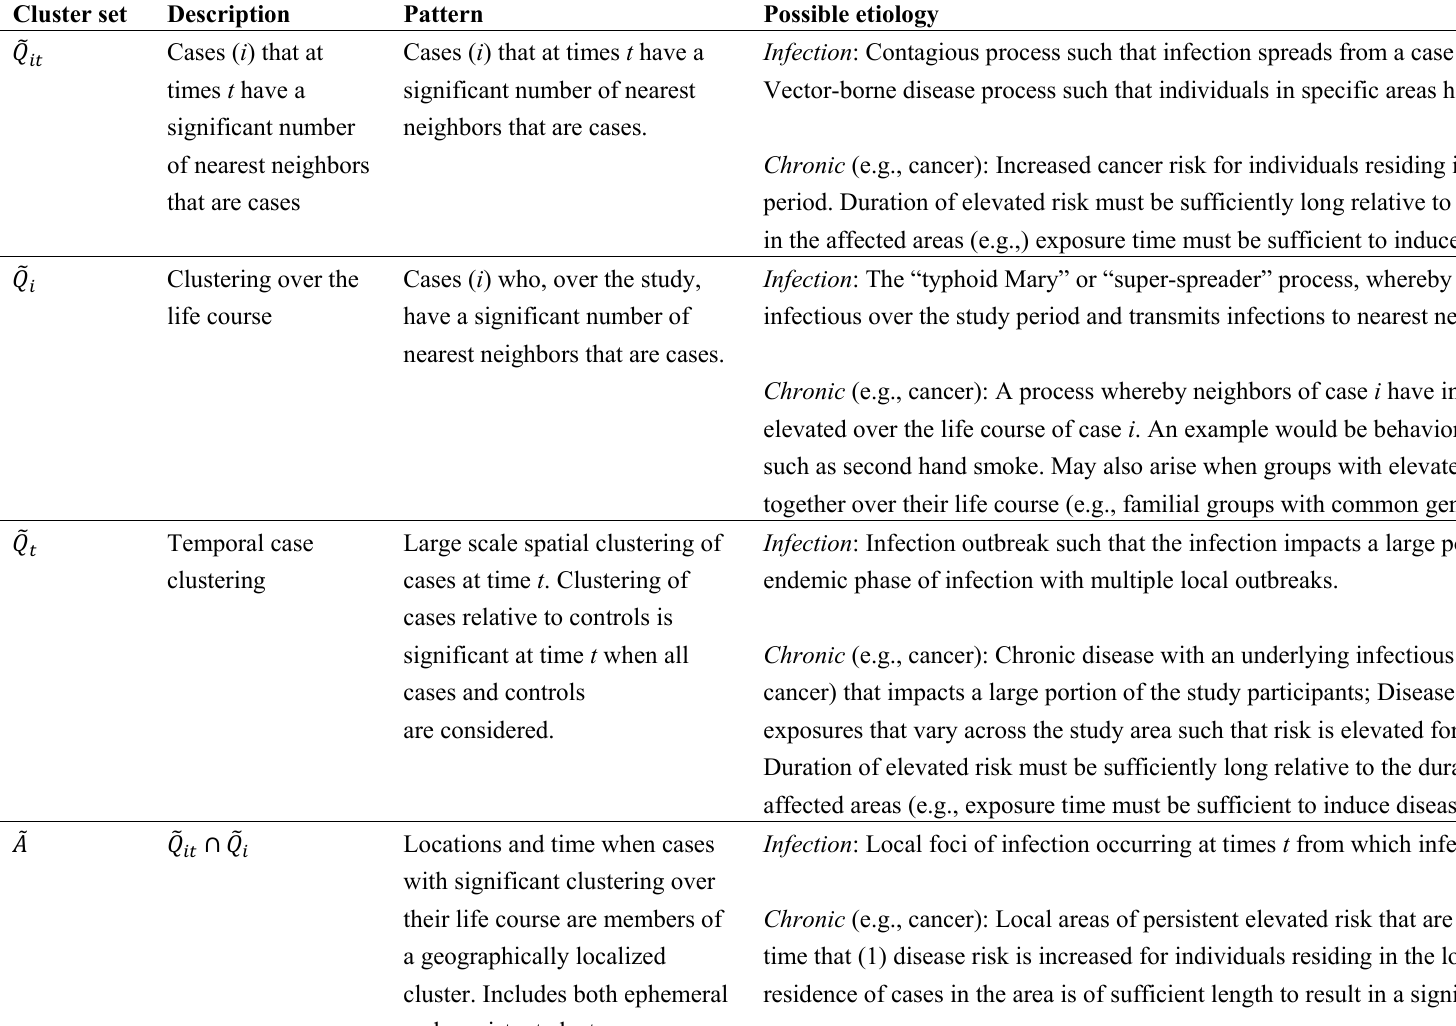
Table 1. Description of cluster sets, summary space-time pattern descriptions, and disease etiologies that may give rise to those patterns. Cluster